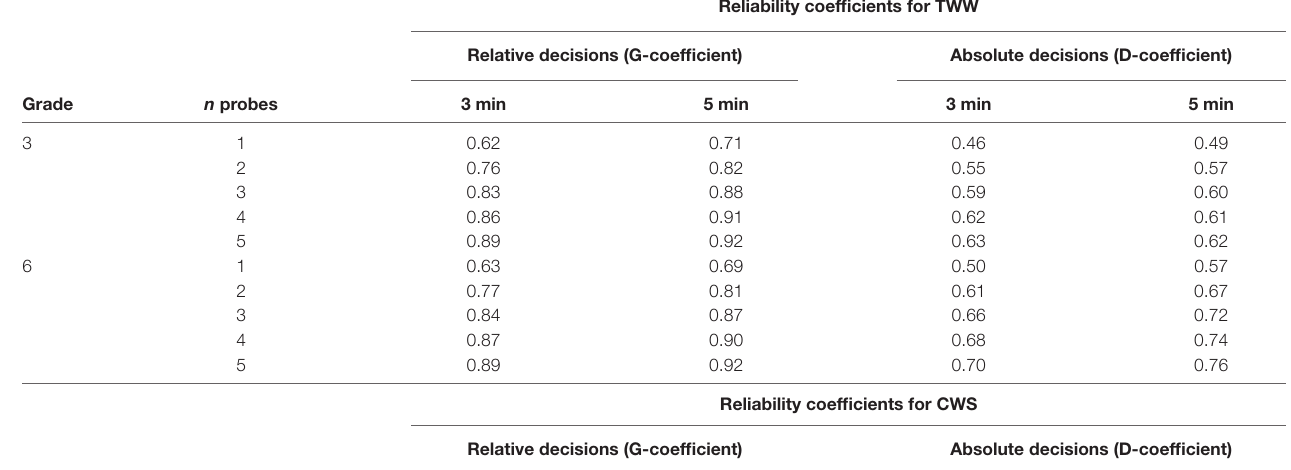
Reliability coefficients for TWW Relative decisions